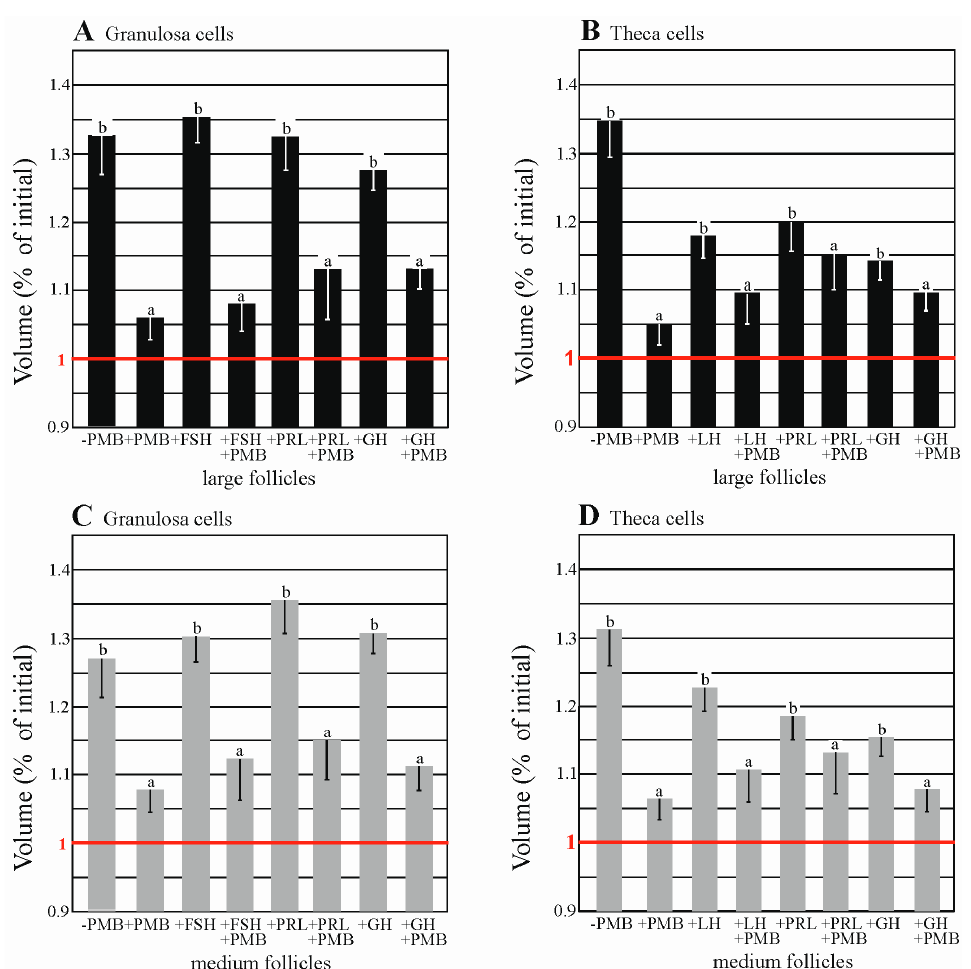
Figure 7. The effect of FSH, LH, PRL and GH on the swelling of the granulosa ( A , C ) and theca ( B , D ) cells of medium and large porcine ovarian follicles in hypotonic medium. In the assay, both groups of cells were randomized into four experimental groups and exposed to the examined factors for 24 h. The first group (+PMB) was the control group. The second group was treated with examined factors without PMB and the third group, after treatment with the studied factors, was incubated with the blocker (+PMB). The fourth group included cells treated without PMB ( − PMB). All of the cells were washed three times with PBS and exposed to hypotonic medium for 30 s. Photographs were taken from 0 to 30 s at intervals of 3 s. An Olympus analysis platform (Olympus, Tokyo, Japan) was used to measure the volume of the cells. Data are mean ± S.E.M of five separated measurements of five separated experiments performed on different days. Statistically significant differences between treatments are indicated by different letters (a, b). 1 = initial volumes at the beginning of the experiments; line in red.